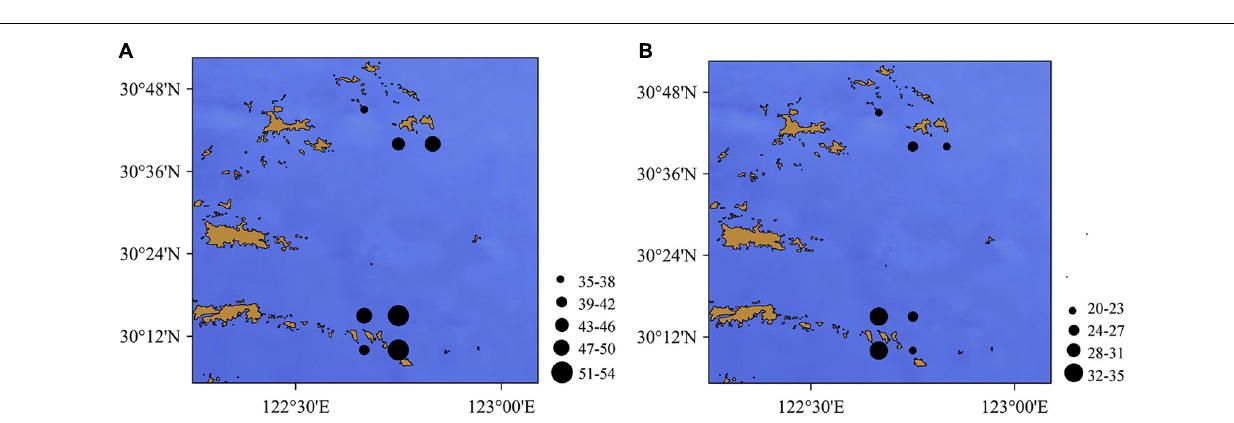
(31.9%), Setipinna taty (15.1%), and Coilia mystus (15.0%). In contrast, the most abundant species according to eDNA metabarcoding were Larimichthys polyactis (28.9%), Miichthys miiuy (28.4%), and Poecilopsetta plinthus (18.7%) ( Figure 6B ). 0.79 and the second axis eigenvalue was 0.11. Monte